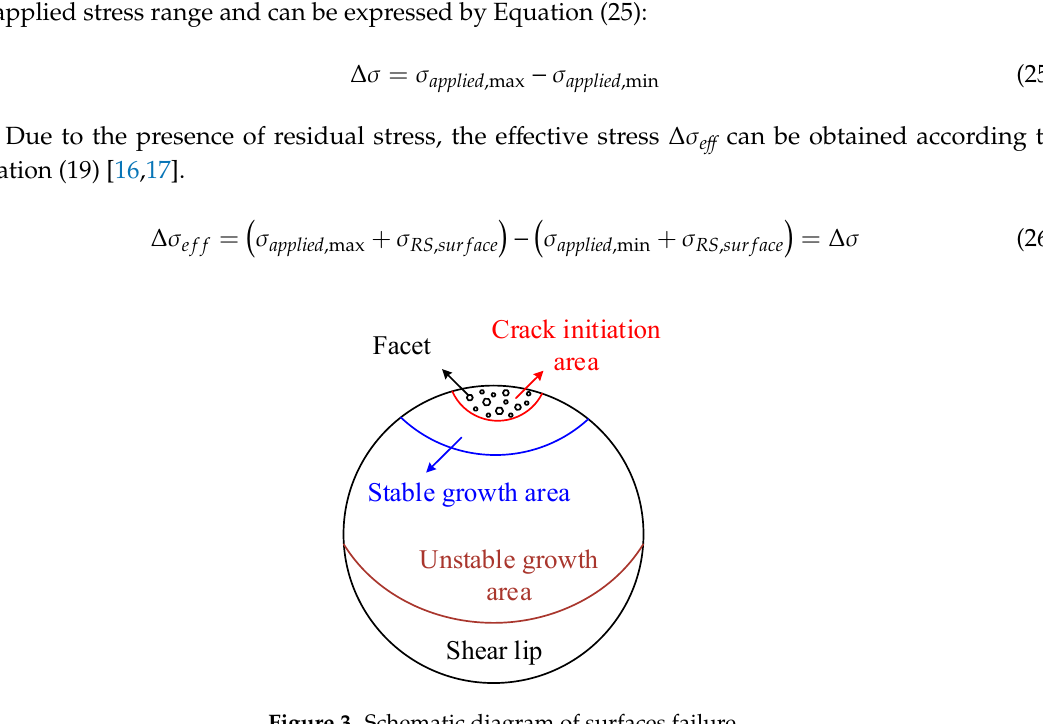
Figure 3. Schematic diagram of surfaces failure.